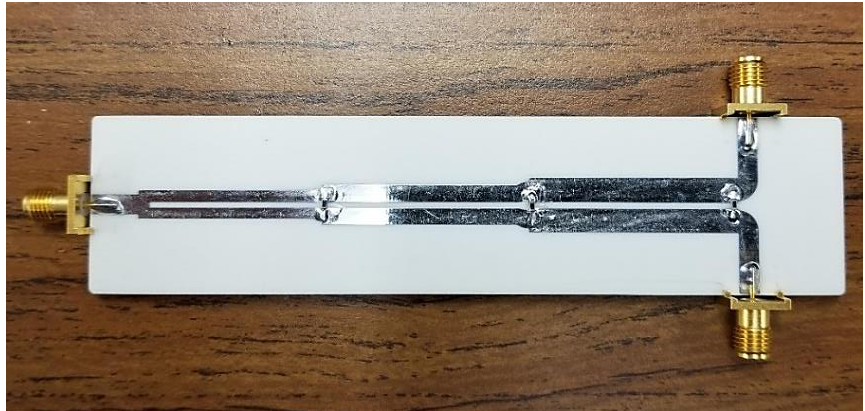
Figure 10. The fabricated prototype of the WPD. The prototype is measured using the Tektronix TTR506A vector network analyzer (VNA) with a full two-port SOLT calibration as shown in Figure 11. The EM simulated and the measured results in the range of 0.3 GHz–2.7 GHz are compared in Figures 12 and 13.